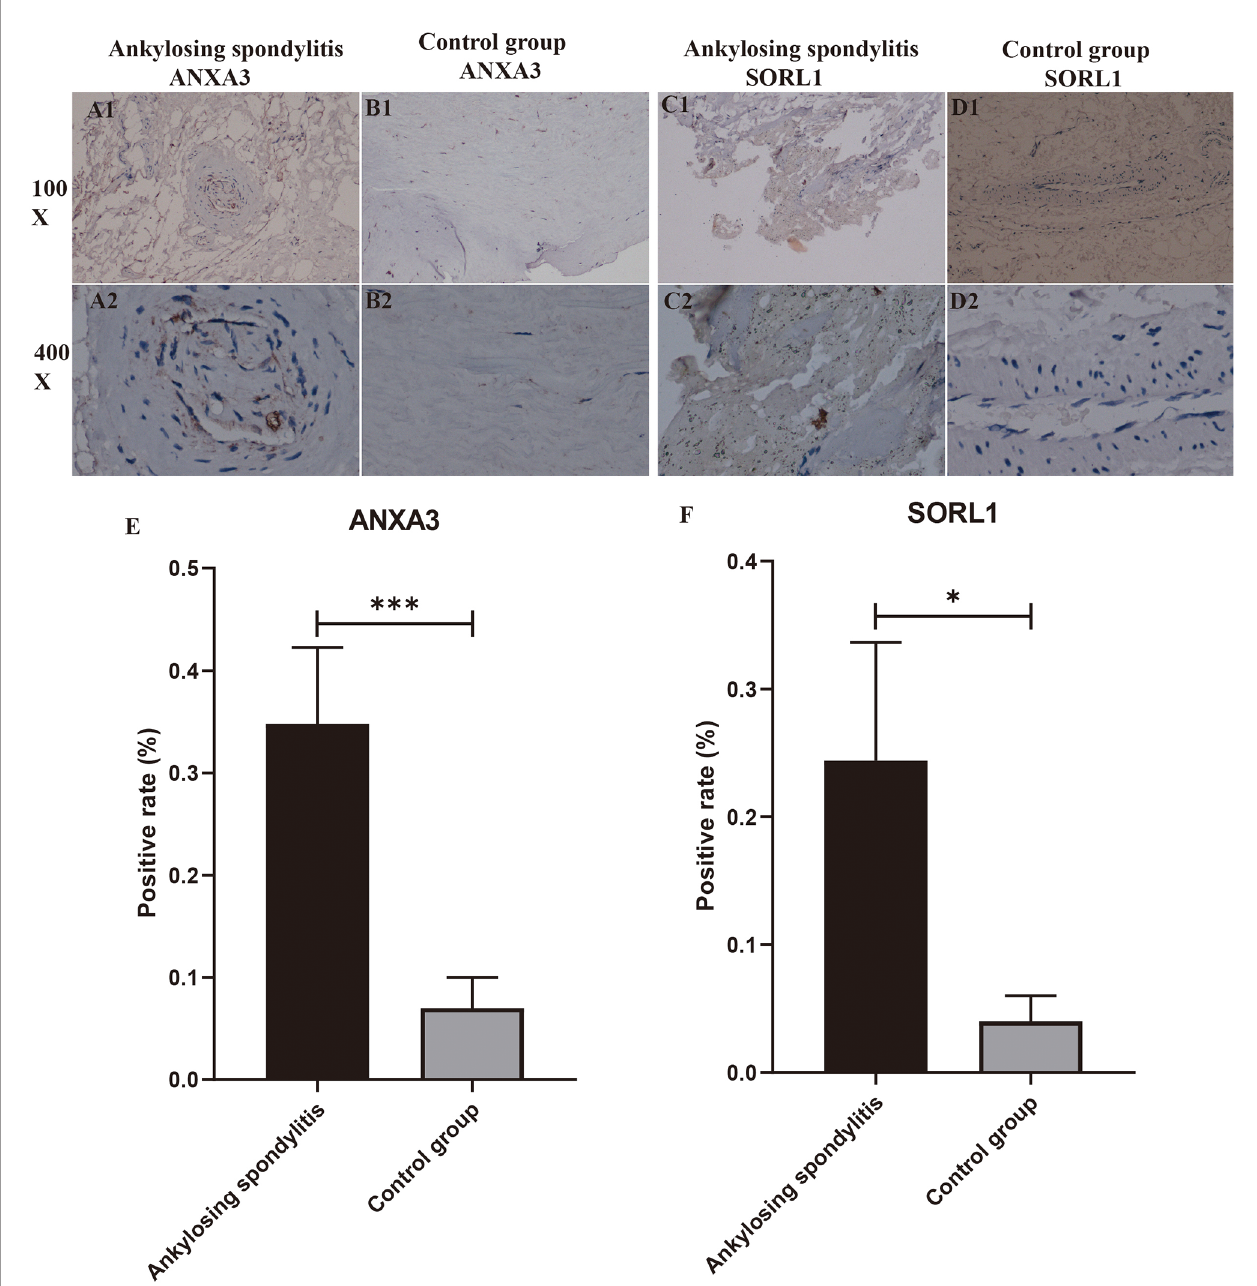
FIGURE 10 | Immunohistochemistry and positive rate statistics. (A1-D2) show the speci fi c expression of ANXA3 with SORL1 in AS and controls. (E, F) shows the positive rate statistics of all immunohistochemical images of SORL1 in AS and control groups. “ * ” indicates p < 0.05, “ *** ” indicates p <